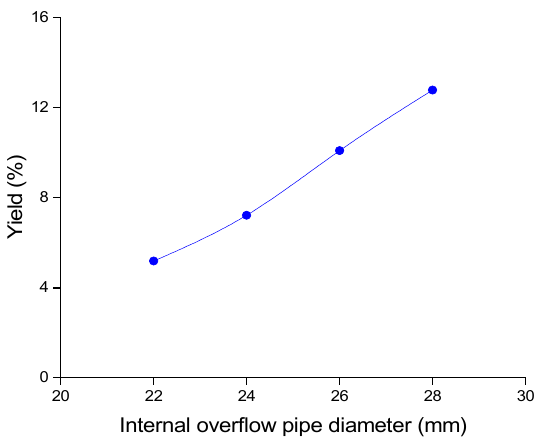
Figure 6. Effect of internal vortex finder diameter on internal overflow yield.